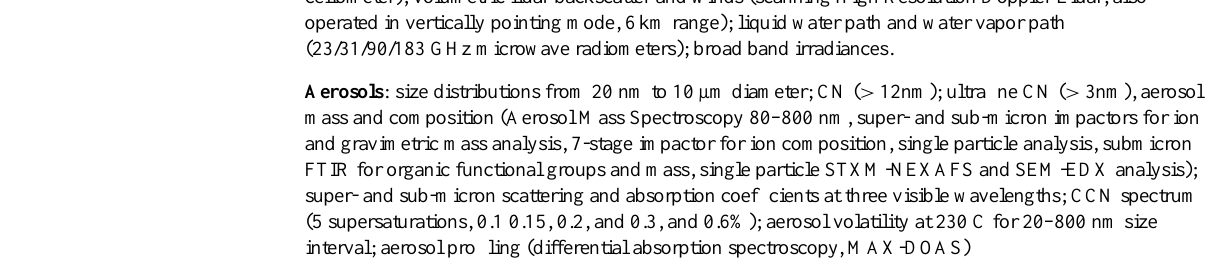
See map Fig. 9 Oct 25 –Dec